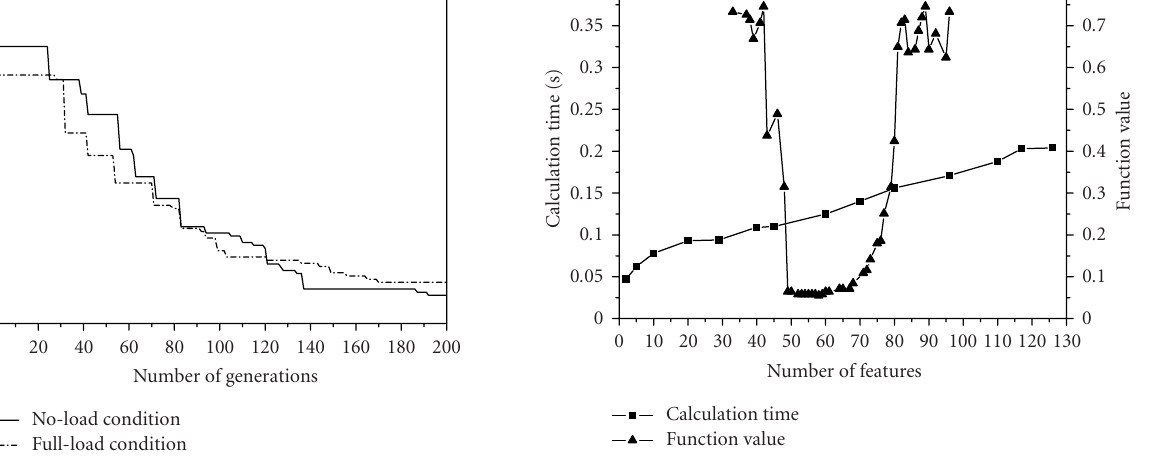
Figure 10: Convergence curves of GA under no-load and full-load conditions.